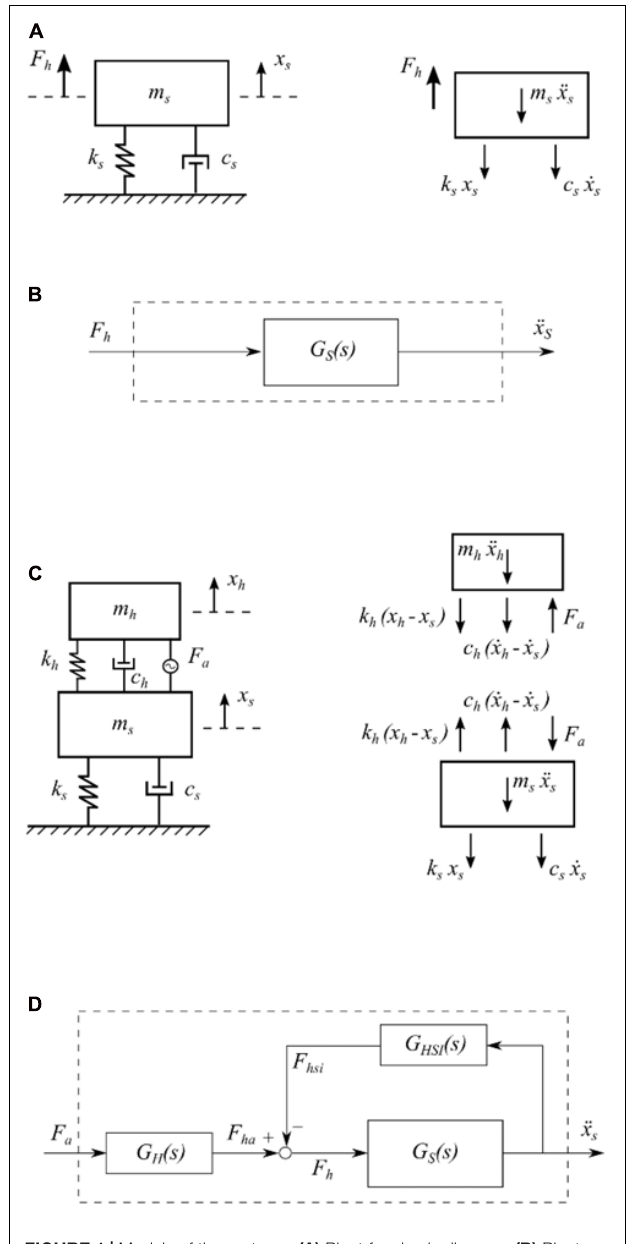
FIGURE 1 | Models of the systems: (A) Plant free body diagram, (B) Plant block diagram, (C) HSI free body diagram, and (D) HSI block